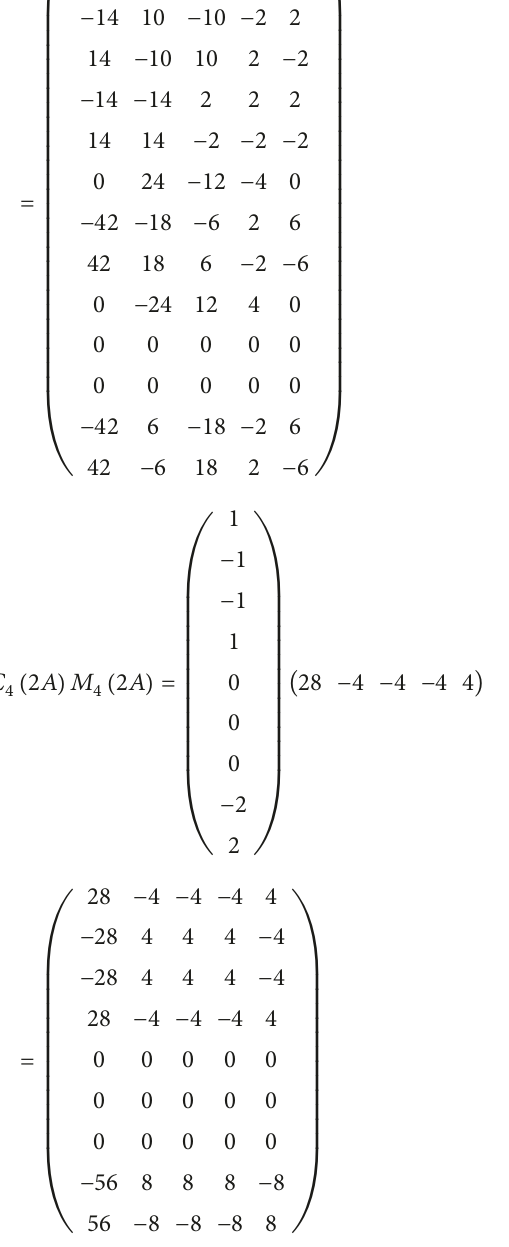
(4) : 2) is shown in 3